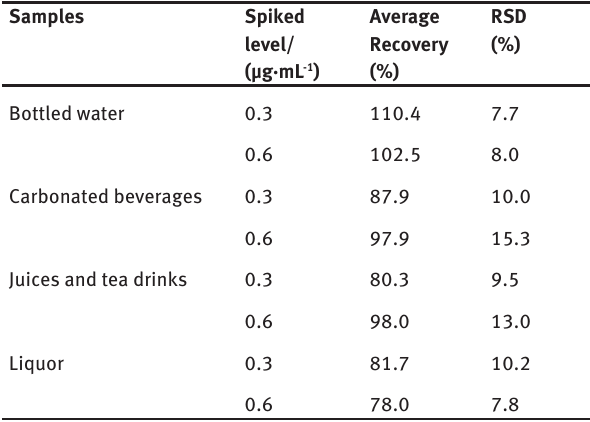
Table 3: Recoveries of DBP spiked in samples ( n =5).